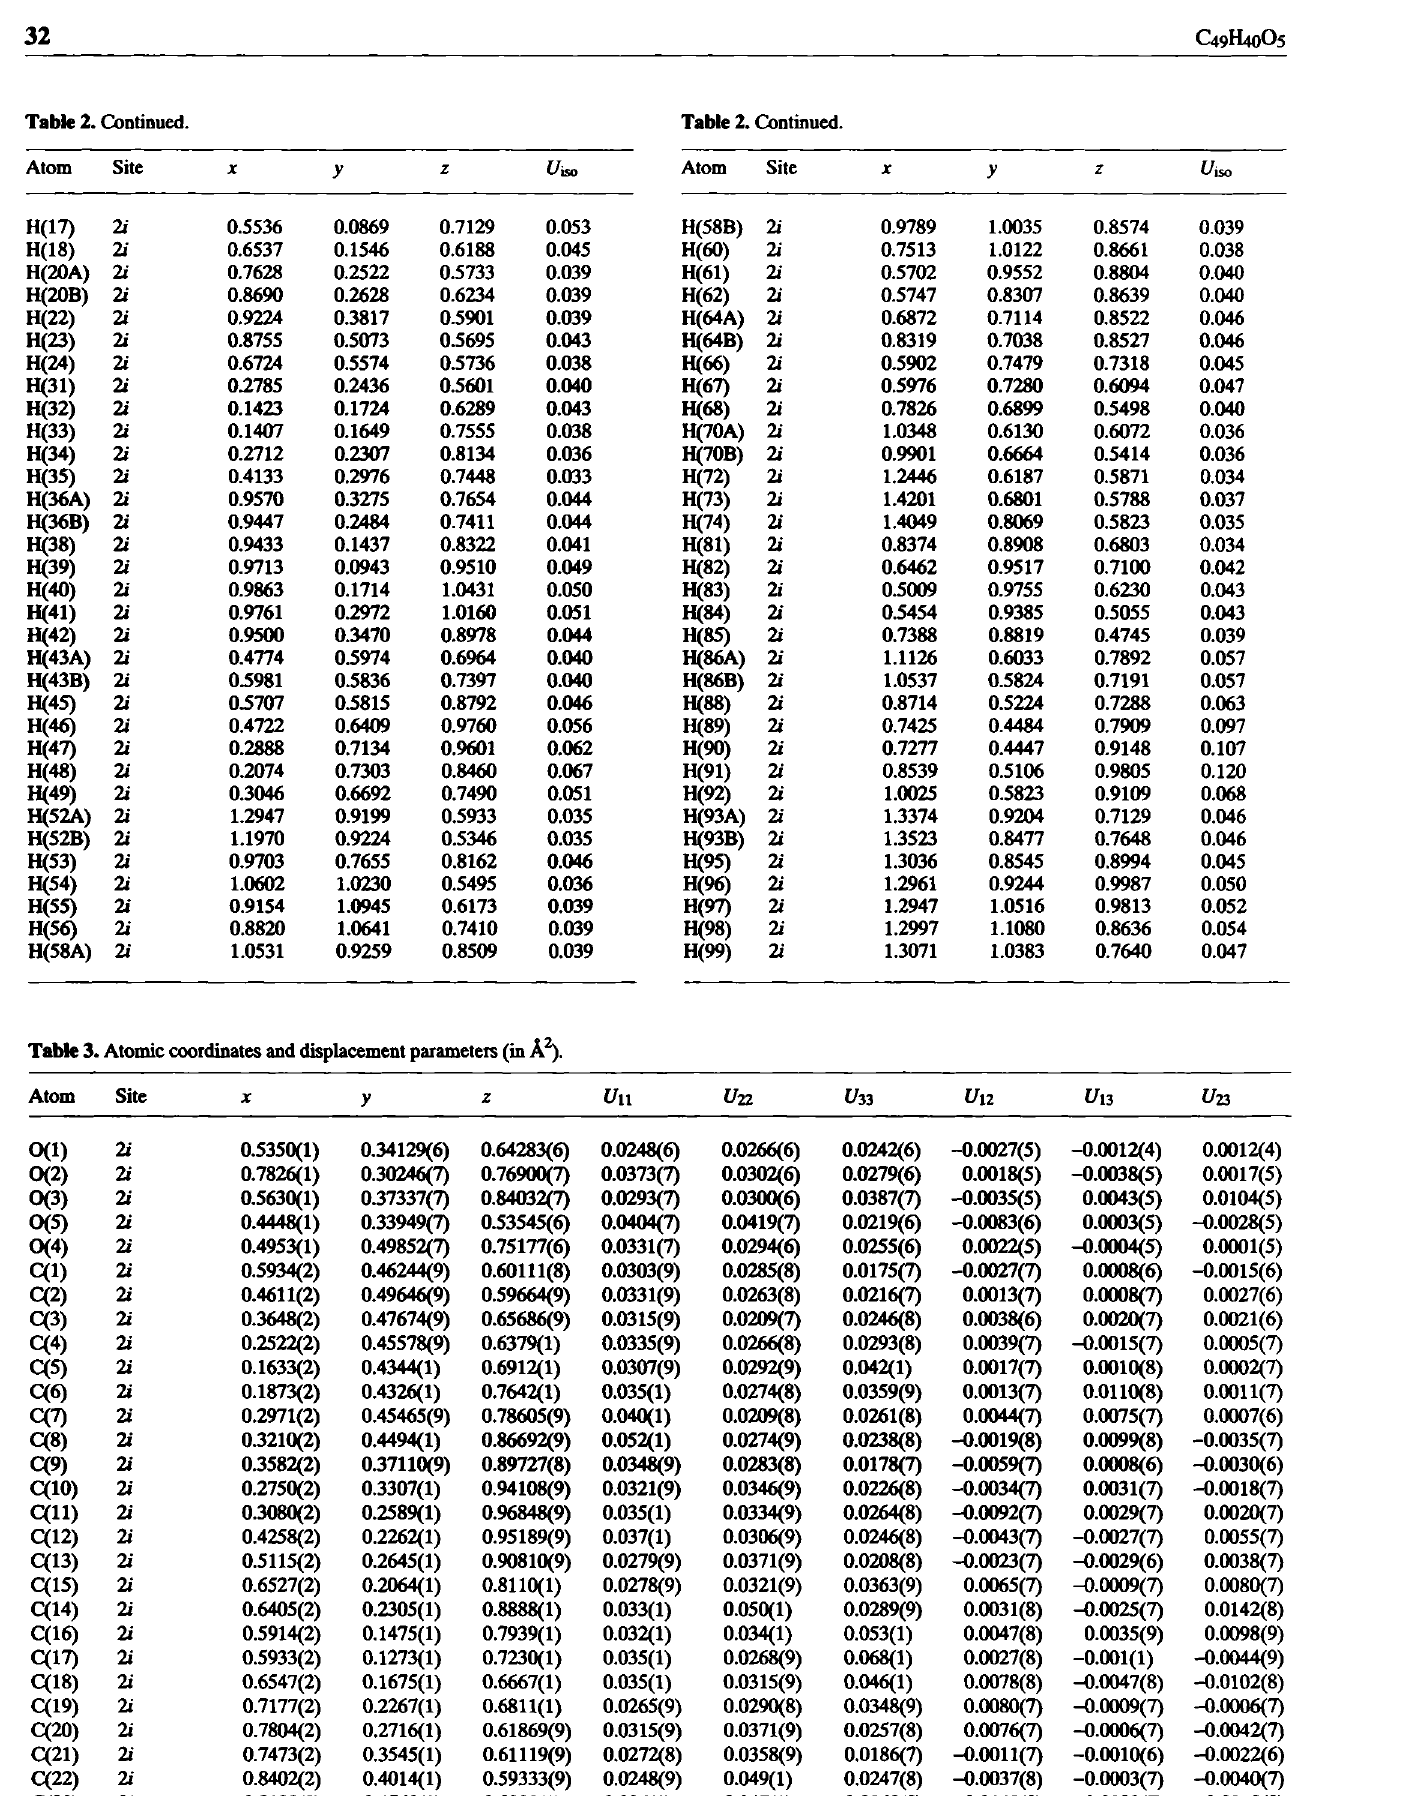
Table 3. Atomic coordinates and displacement parameters (in Ä 2